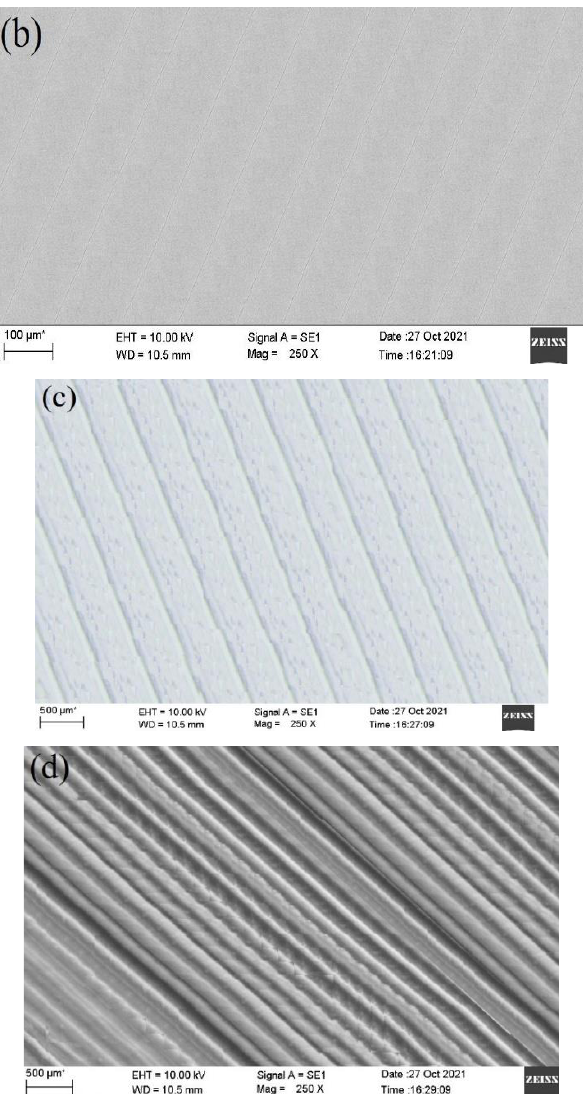
Figure 3. FESEM images of specimens Ni 50 − x Fe x Mn 30 Sn 20 − y In y where 1 ≤ x ≤ 4; 2 ≤ y ≤ 8 alloy ( a ) x = 1 ( b ) x= 2 ( c ) x = 3 ( d ) x = 4 .